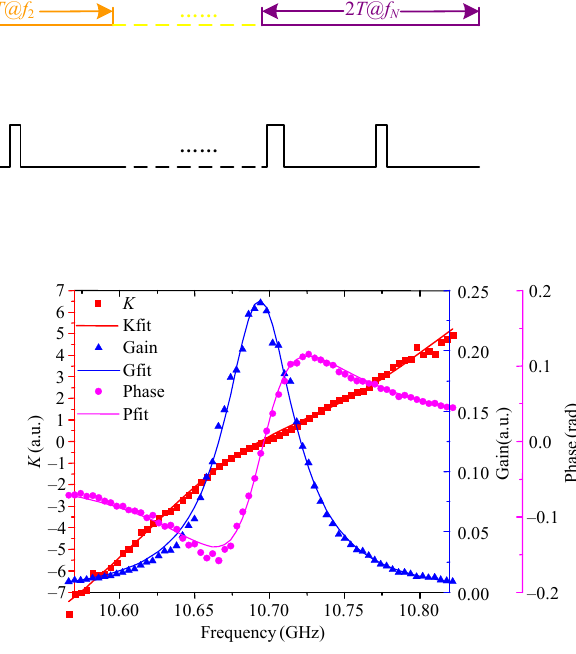
Fig. 11 Different spectra (gain, phase, and K ) for a 20-ns pump pulse